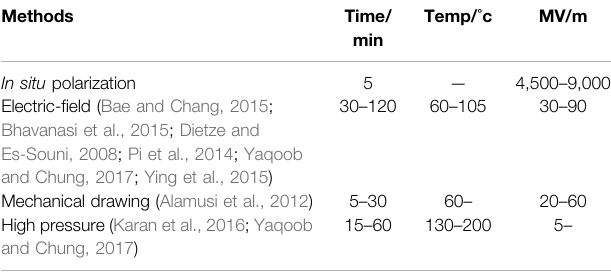
TABLE 1 | Comparison of in situ polarization and common methods.